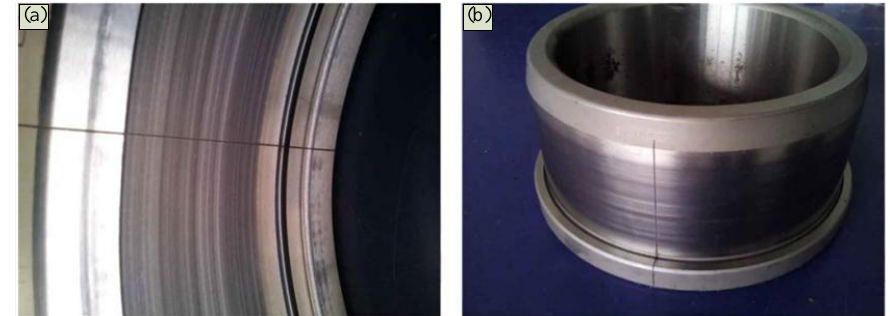
Figure 9. Artificial defects on the ( a ) outer race and ( b ) on the inner race of the bearing.